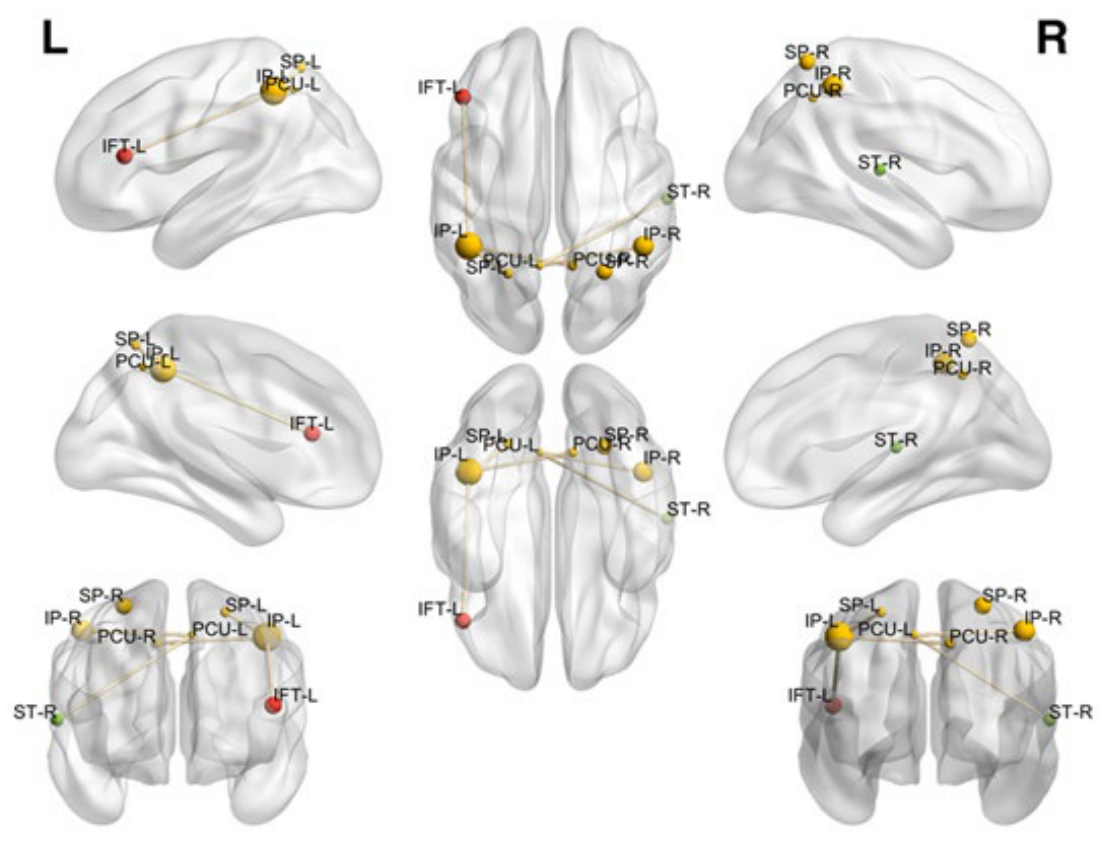
Figure 3. Connectivity pattern among most influential nodes at 4 Hz (T = 3.5, p < 0.001). L: left, R: right, PCU-L: left precuneus, PCU-R: right precuneus, SP-L: left superior parietal gyrus, ST-R: right superior temporal gyrus, IFT-L: left Inferior frontal gyrus, triangular part, SP-R: right superior parietal gyrus, IP-R: right Inferior parietal, but supramarginal and angular gyri, IP-L: left Inferior parietal, but supramarginal and angular gyri.